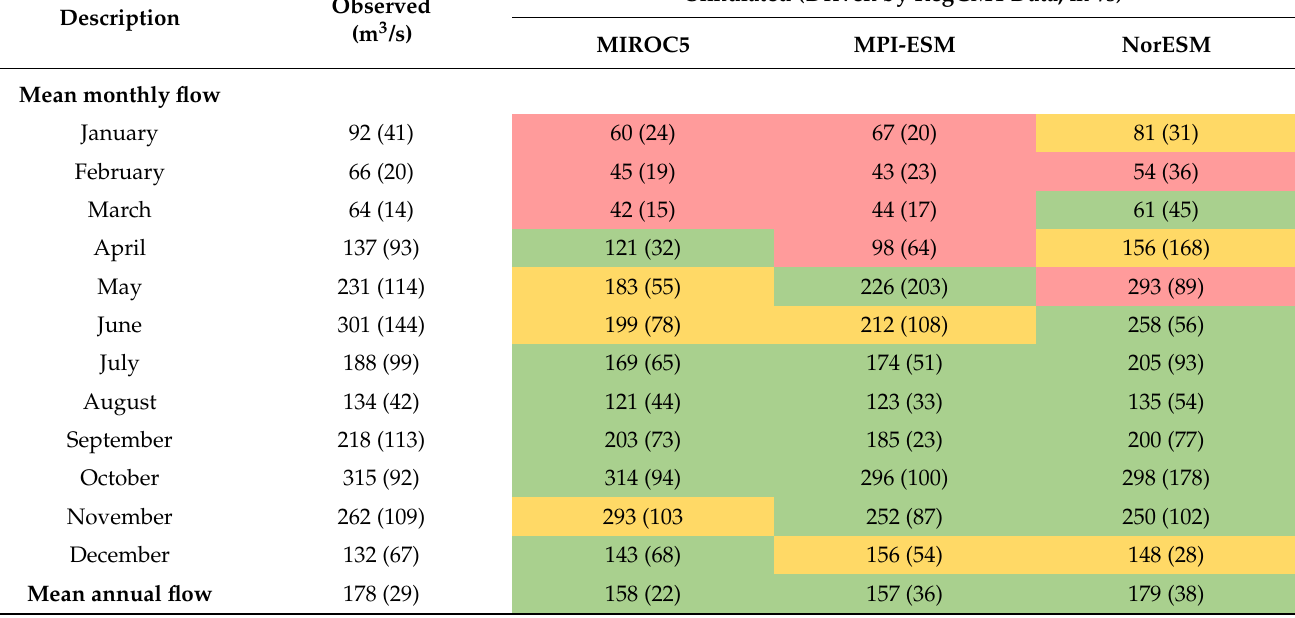
Table 2. Comparison of observed and simulated hydrological indices (mean and standard deviation (within bracket) based on monthly average streamflow) at Putupaula Gauging station (located near to the Kalu Basin Outlet) for 1991–2000. “Green, yellow, and red” represent the simulated streamflow value within ± 10%, within ± 20%, and beyond ± 20% of observed streamflow, respectively.